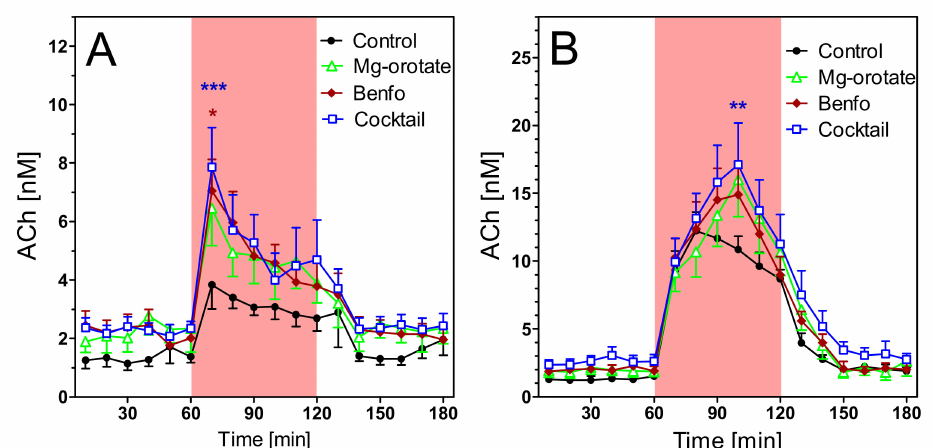
Figure 10. Extracellular ACh concentrations in hippocampus of young (6–7 months old) transgenic rats during open field test ( A ) and during scopolamine perfusion ( B ). The rats submitted to 4 different treatments for 14 days: no treatment (“control”), magnesium orotate, benfotiamine and cocktail. Red area represents intervention (open field exposure or scopolamine perfusion) from 60–120 min. Data are means ± SEM ( n =7–8) and were analysed by two-way ANOVA for treatment as variable followed by Bonferroni’s multiple comparison test: ( A ) F3,442 = 0.90, p = 0.27 ( B ) F3,442 = 1.04, p = 0.41. Comparison of “control” to “cocktail”: F1,204 = 4.52; p = 0.055. * p < 0.05, ** p < 0.01, *** p < 0.001.